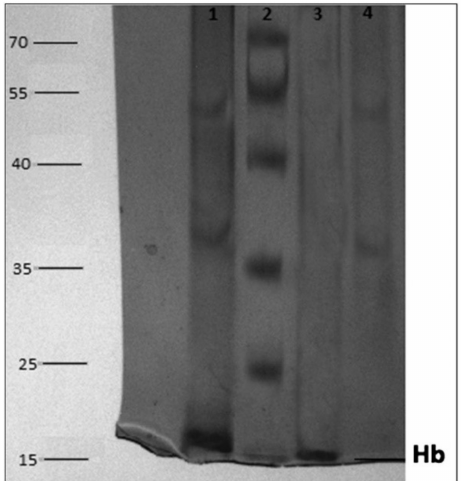
Figure 7. Electrophoresis image of hemolysate fractions under reducing conditions. Republished with permission from [53]; Copyright 2014 Wiley.